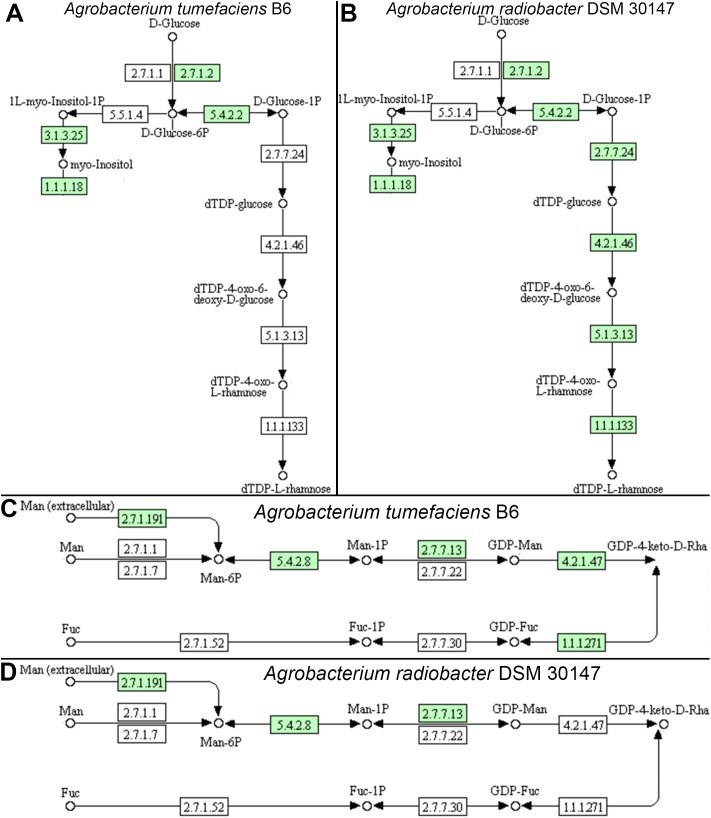
KEGG pathway of nucleotide sugar metabolism associated with Agrobacterium lipopolysaccharide synthesis.(A & B) genomic potential of A. tumefaciens B6 and A. radiobacter DSM 30147, respectively, in the biosynthesis of dTDP-L-rhamnose. (C & D) genomic potential of A. tumefaciens B6 and A. radiobacter DSM 30147, respectively, in the biosynthesis of GDP-L-Fucose. Numbers in boxes indicate Enzyme Commission numbers. White and green boxes indicate absence and presence of the corresponding enzymes, respectively, based on GhostKoala annotation (Kanehisa, Sato & Morishima, 2016b).